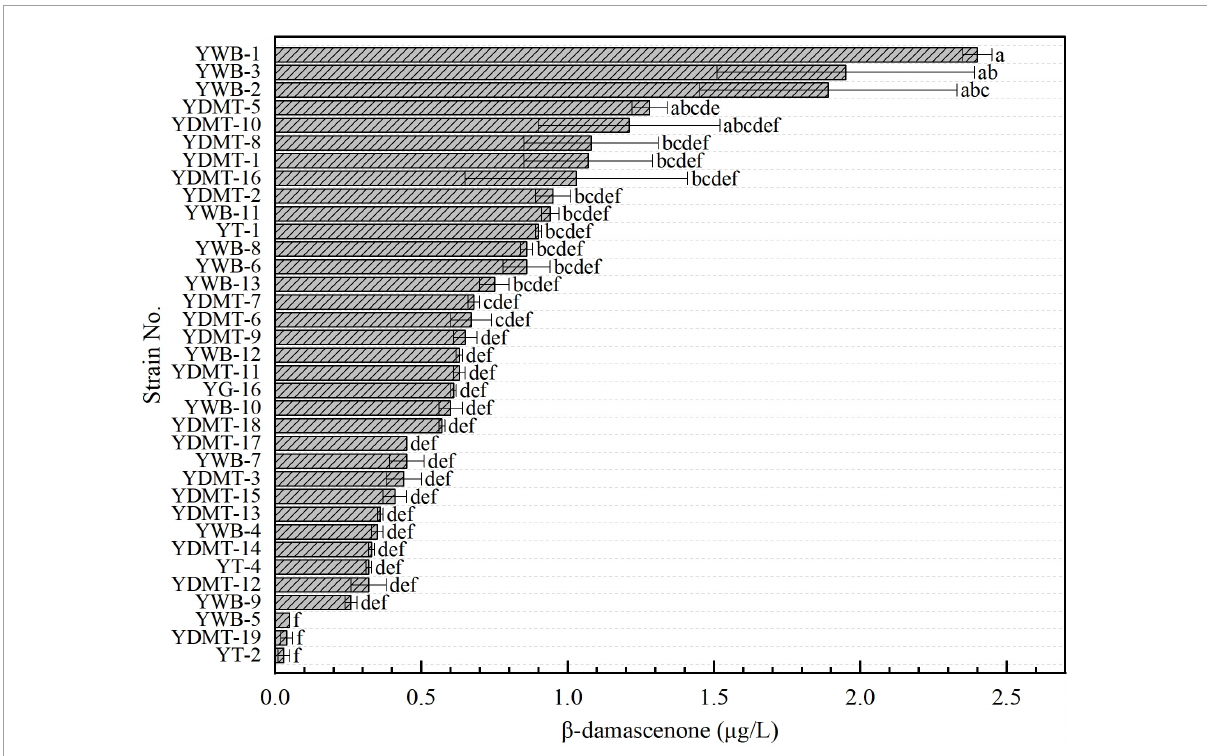
FIGURE2 The β -damascenone concentrations of yeast supernatants. Values (means ± SD, n = 3) marked with the different lowercase letters represent significant difference ( p < 0.05, Duncan’s